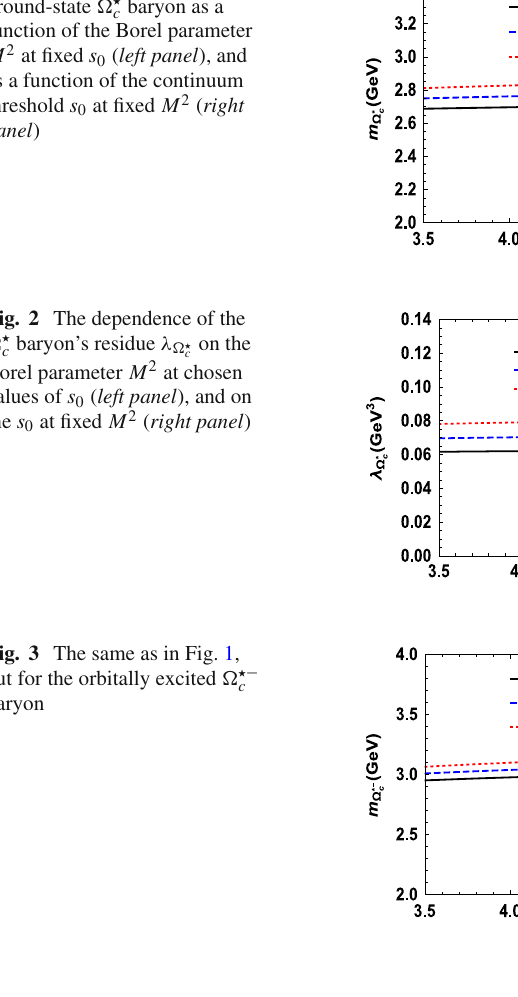
Fig. 1 The mass of the ground-state (cid:2) (cid:4) c baryon as a function of the Borel parameter M 2 at fixed s 0 ( left panel ), and as a function of the continuum threshold s 0 at fixed M 2 ( right panel )